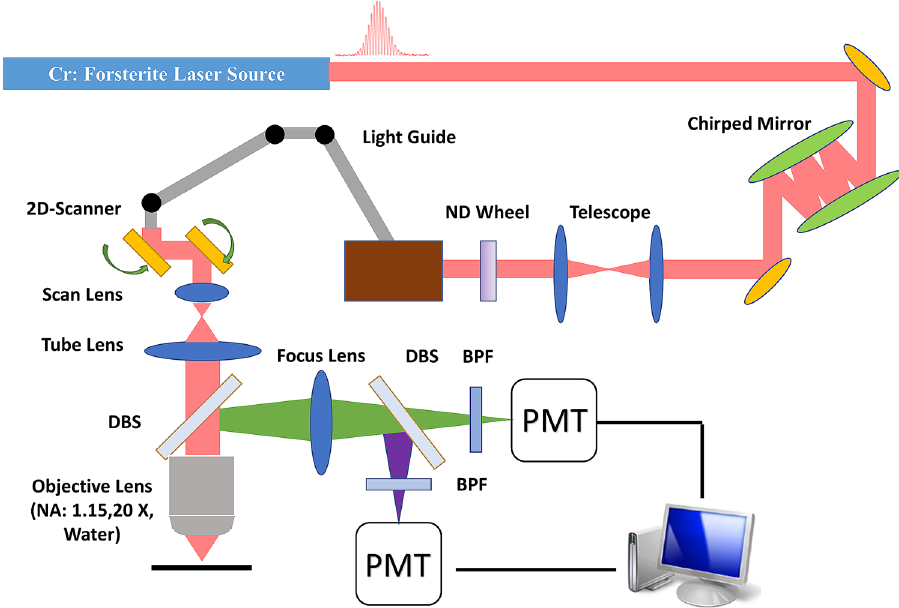
Figure 10. The schematic diagram showing the harmonic generation microscope system. DBS Dichroic beam splitter, BPF Band-pass filter, PMT Photomultiplier tube, ND neutral